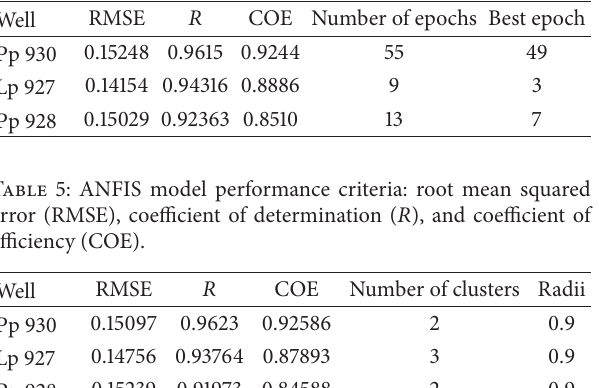
Table 4: ANN model performance criteria: root mean squared error (RMSE), coefficient of determination ( 𝑅 ), and coefficient of efficiency (COE).